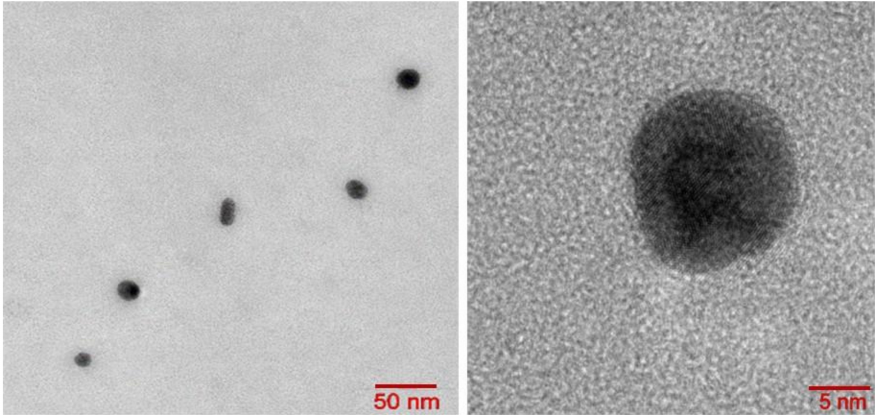
Figure 8. Low- and high magnification TEM images of Si NPs produced during ns-laser ablation of bulk Si in water at the laser intensity of 2.5 GW/cm 2 .